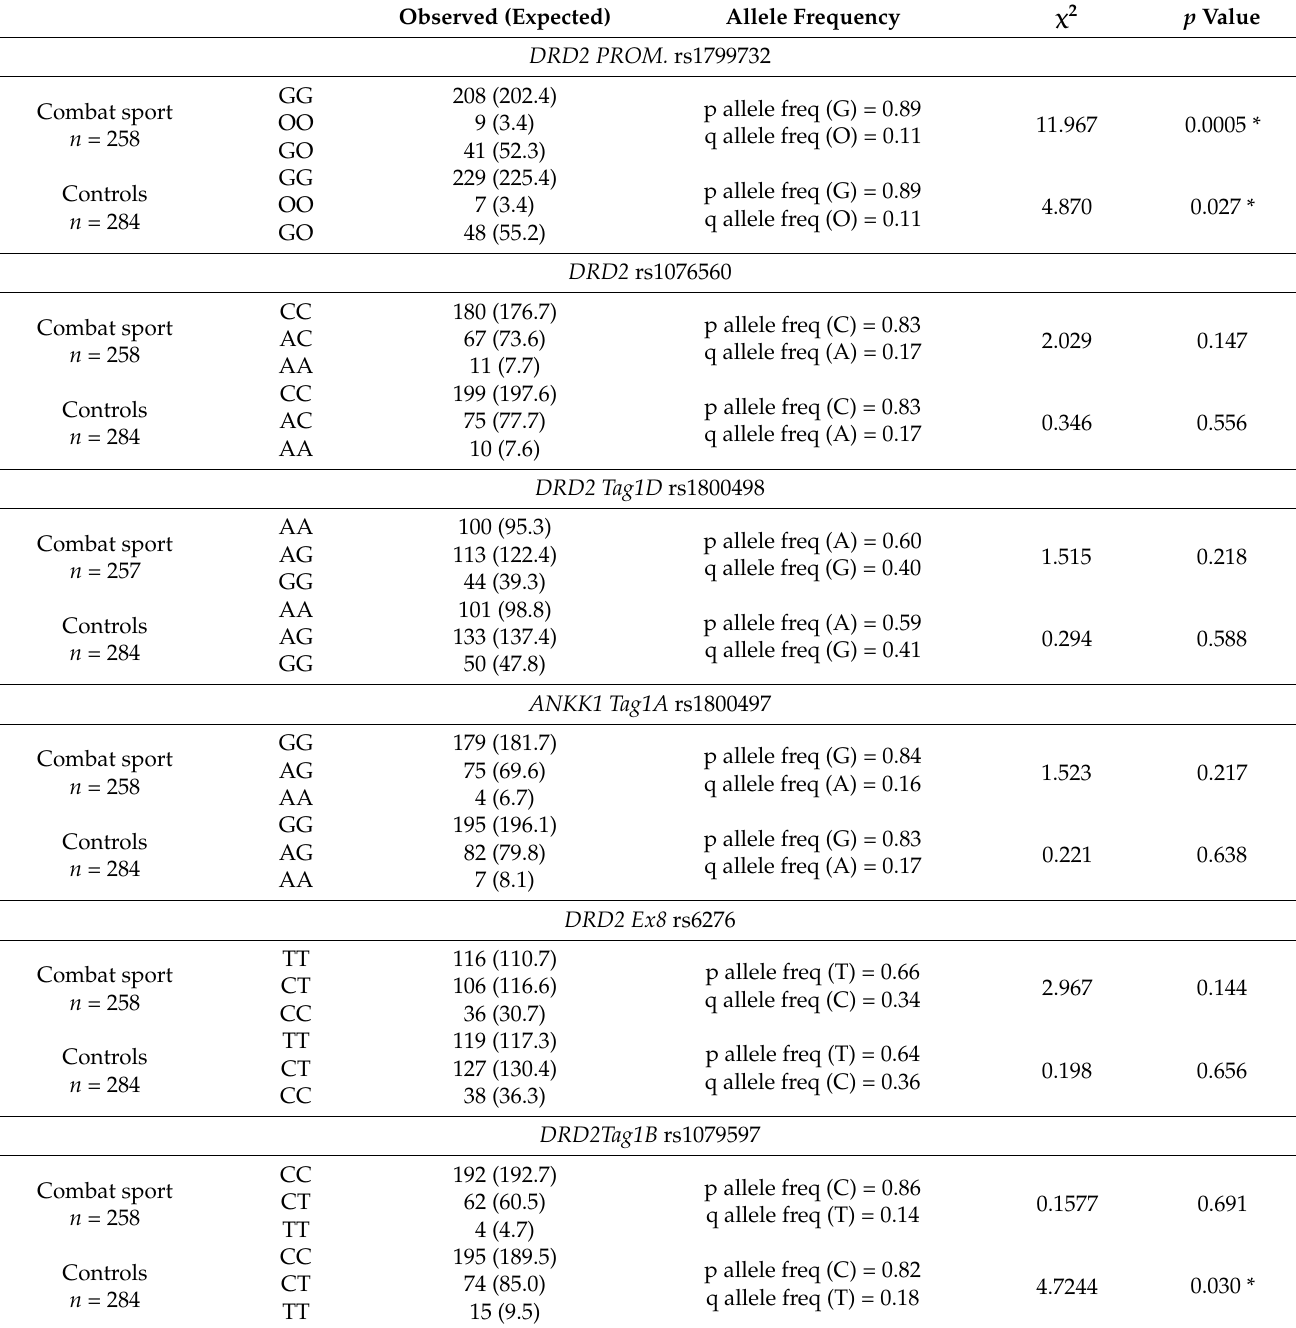
Table 1. Hardy–Weinberg equilibrium of DRD2 PROM . rs1799732, DRD2 rs1076560, DRD2 Tag1D rs1800498, DRD2 Ex8 rs6276, DRD2Tag1B rs1079597 and ANKK1 Tag1A rs1800497 in combat sport and control